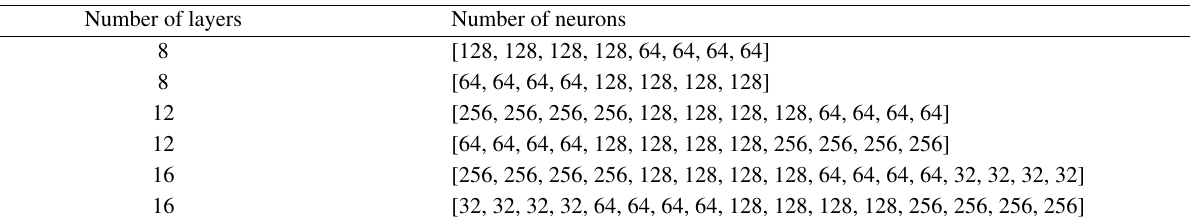
Table 2 Model configurations of